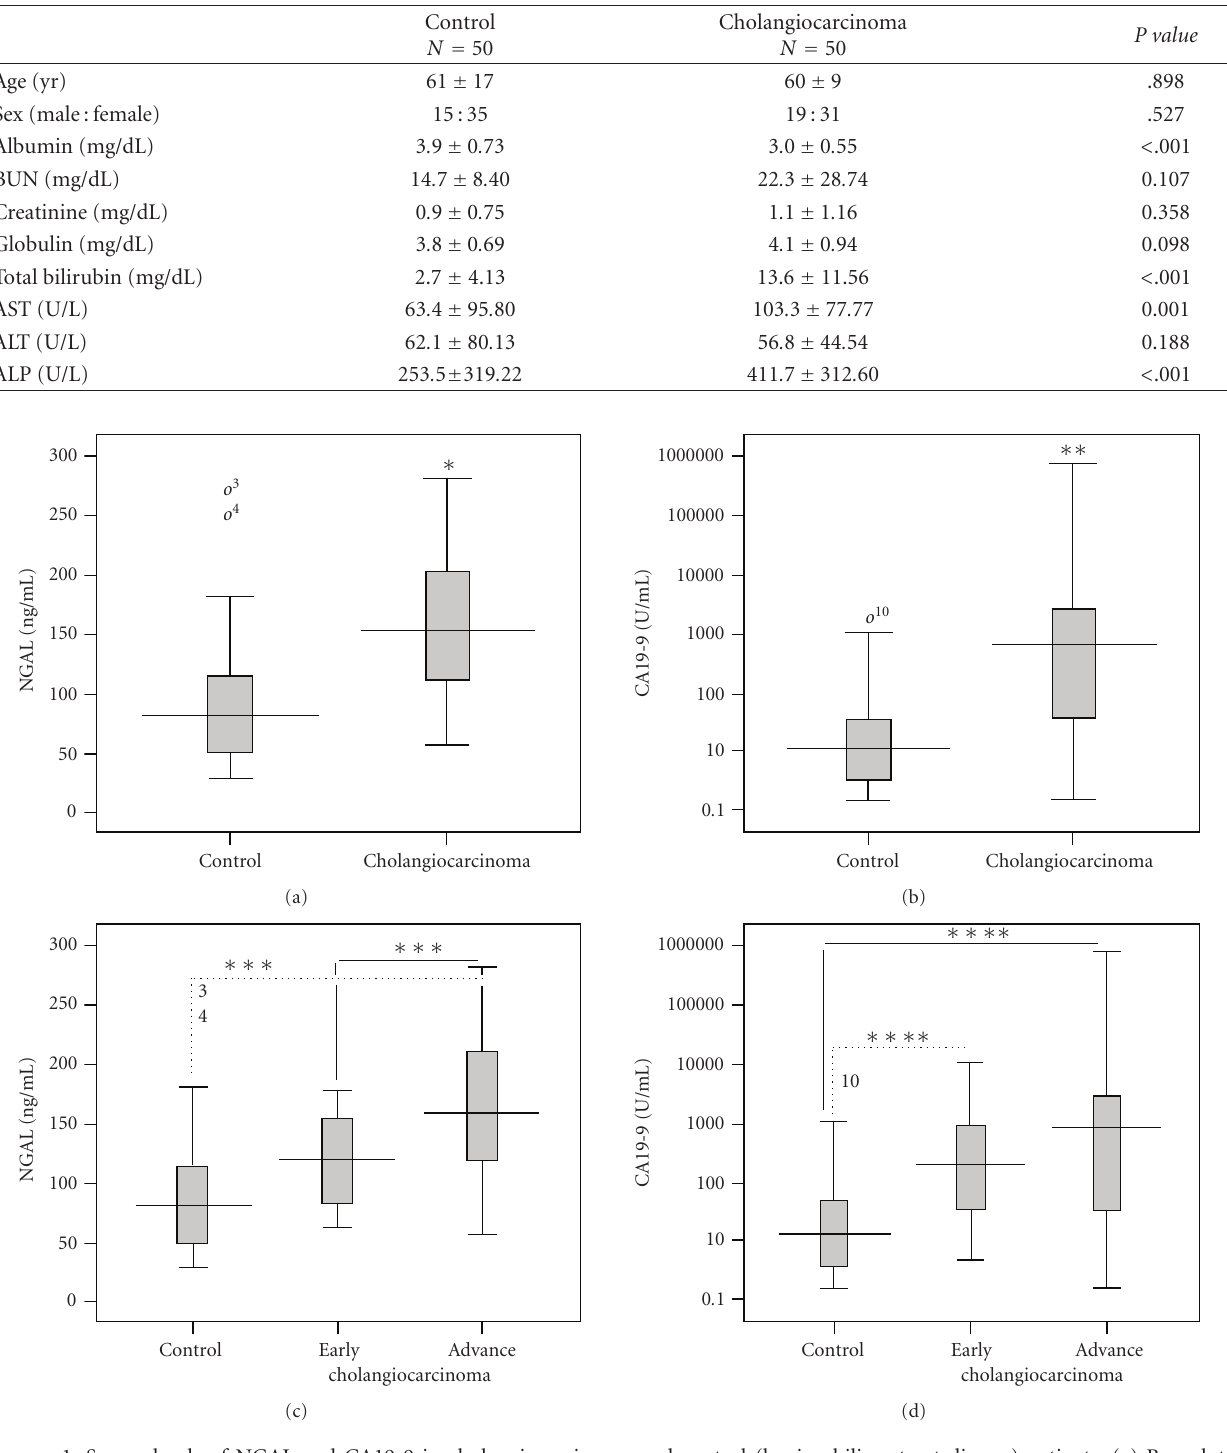
Figure 1: Serum levels of NGAL and CA19-9 in cholangiocarcinoma and control (benign biliary tract disease) patients. (a) Box plots comparing levels of NGAL and (b) CA19-9 between cholangiocarcinoma and control are illustrated. (c) Box plots comparing levels of NGAL and (d) CA19-9 between early and advanced stages of cholangiocarcinoma and control are illustrated. Levels of NGAL are presented as ng/mL, whereas CA19-9 is presented with the log data to accommodate the wide range. ( ∗ ; Mann-Whitney U; P < . 001 compared to control, ∗∗ ; Student’s t -test; P < . 001 compared to control, ∗∗∗ ; Kruskal-Wallis test; P < . 001 compared to control, ∗∗∗∗ ; ANOVA; P < . 001 compared to